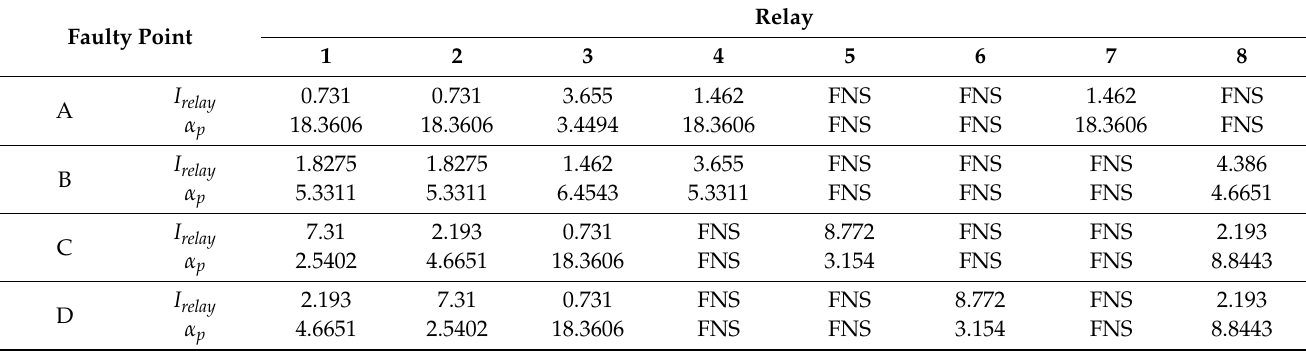
Table 8. Calculations of I relay (current through relay) and α p (constant) (Case